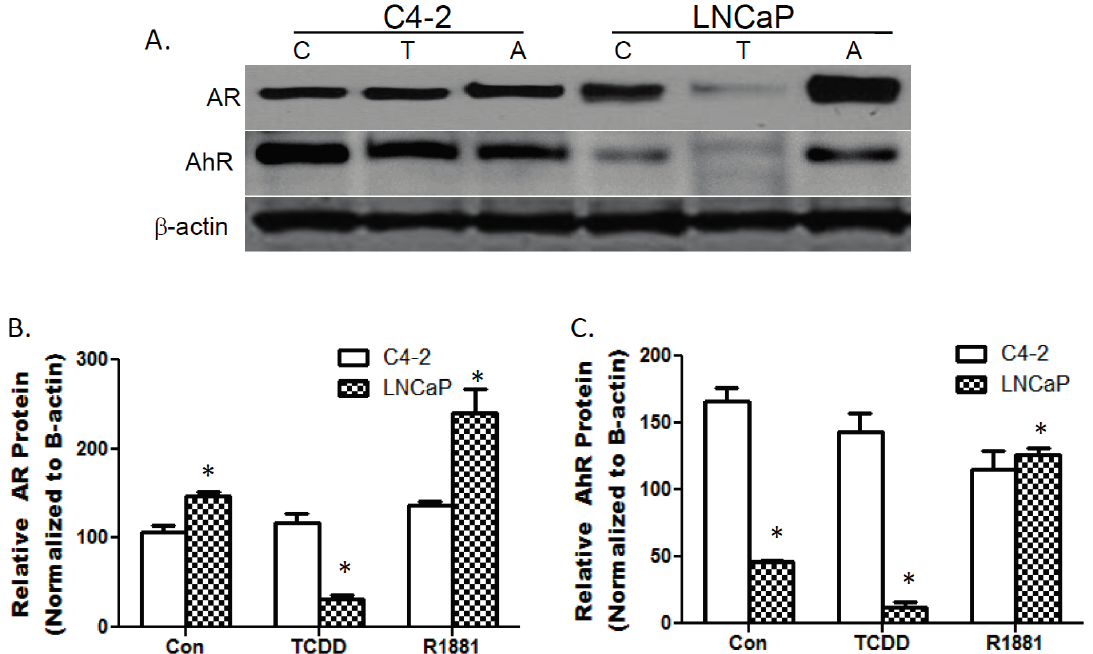
Figure 1. TCDD decreases AhR and AR protein expression in LNCaP cells. LNCaP and C4-2 cells were treated with DMSO (C), 10 μ M TCDD (T) or 10nM R1881 (A) for 24 h. Total protein transferred to a PVDF membrane was probed with AhR and AR antibodies ( A ). Bottom left panel is representative of AR protein expression ( B ) and bottom right panel of AhR protein expression ( C ). Image J was used to obtain densitometric measures from 3 independent membranes separately for AR and AhR. Each bar represents mean +